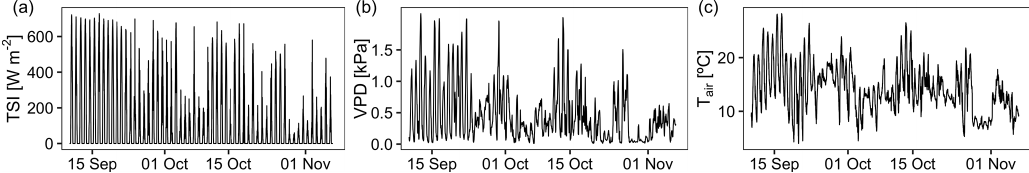
Figure 2. Weather conditions for the study site over the course of the experiment. Data are provided by the German Weather Service station Freiburg im Breisgau, Germany, less than 1km